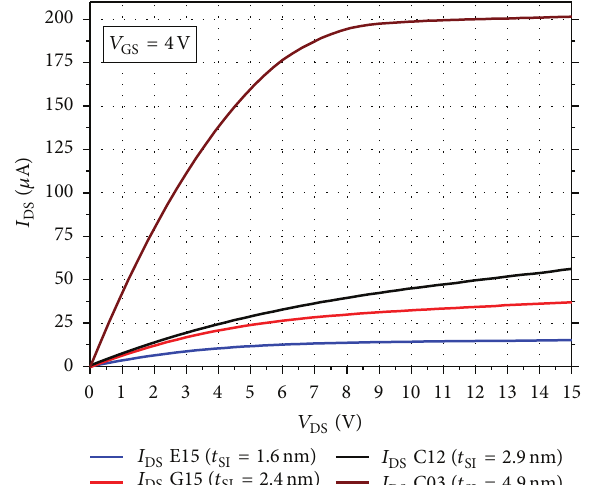
Figure 9: Measured saturation current (for 𝑉 15 V) versus channel thickness for NSB devices and fitted by the model given by